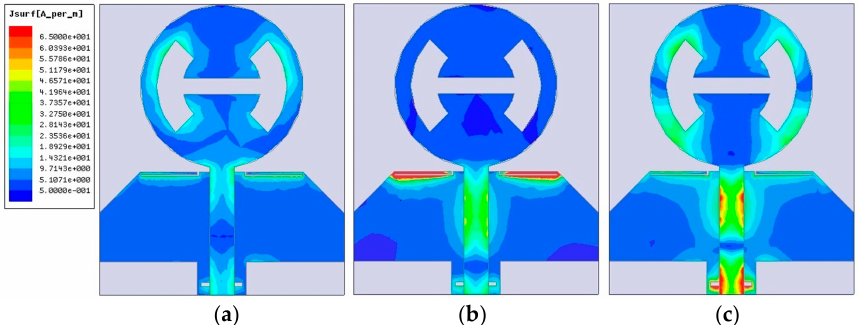
Figure 3. Simulated surface current distributions at ( a ) 3.8 GHz, ( b ) 5.6 GHz, and ( c ) 8.1 GHz.